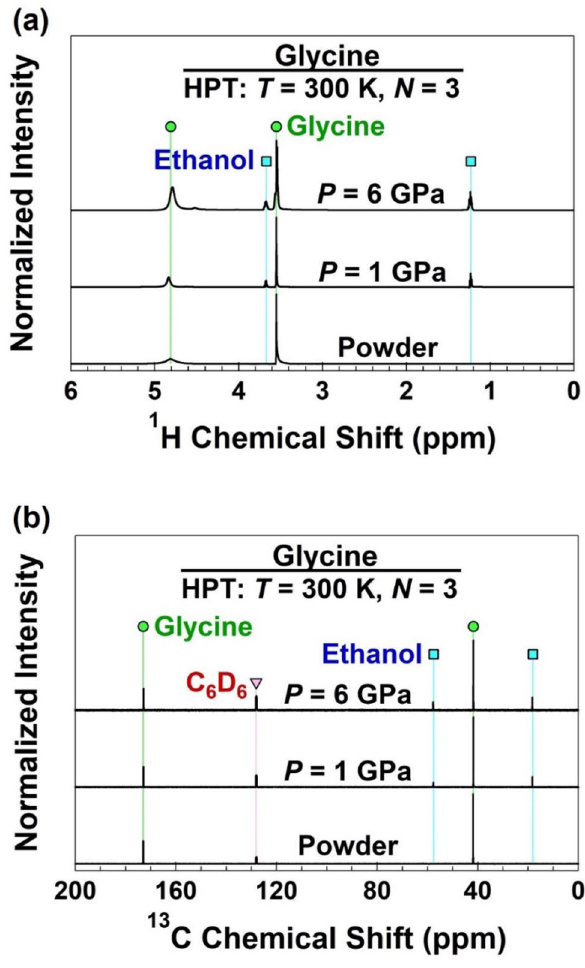
Figure 3. Absence of polymerization and occurrence of transformation to ethanol in glycine by high-pressure torsion processing. NMR ( a ) 1 H and ( b ) 13 C spectra of glycine before and after processing under 1 and 6